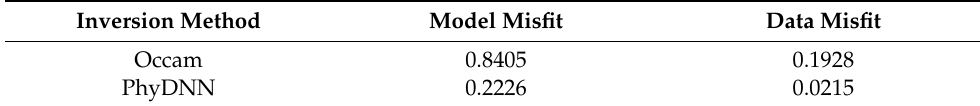
Table 3. Mean model and data misfits of the test set for Occam and PhyDNN.